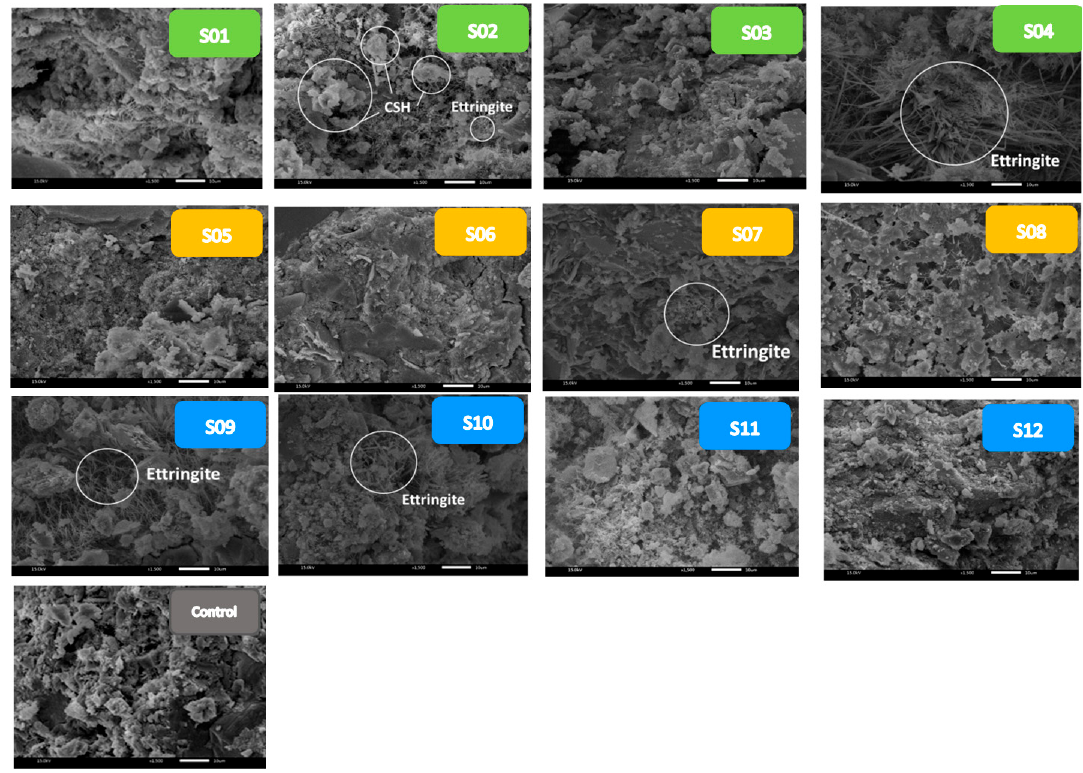
Figure 9. The microstructures of concrete bricks.